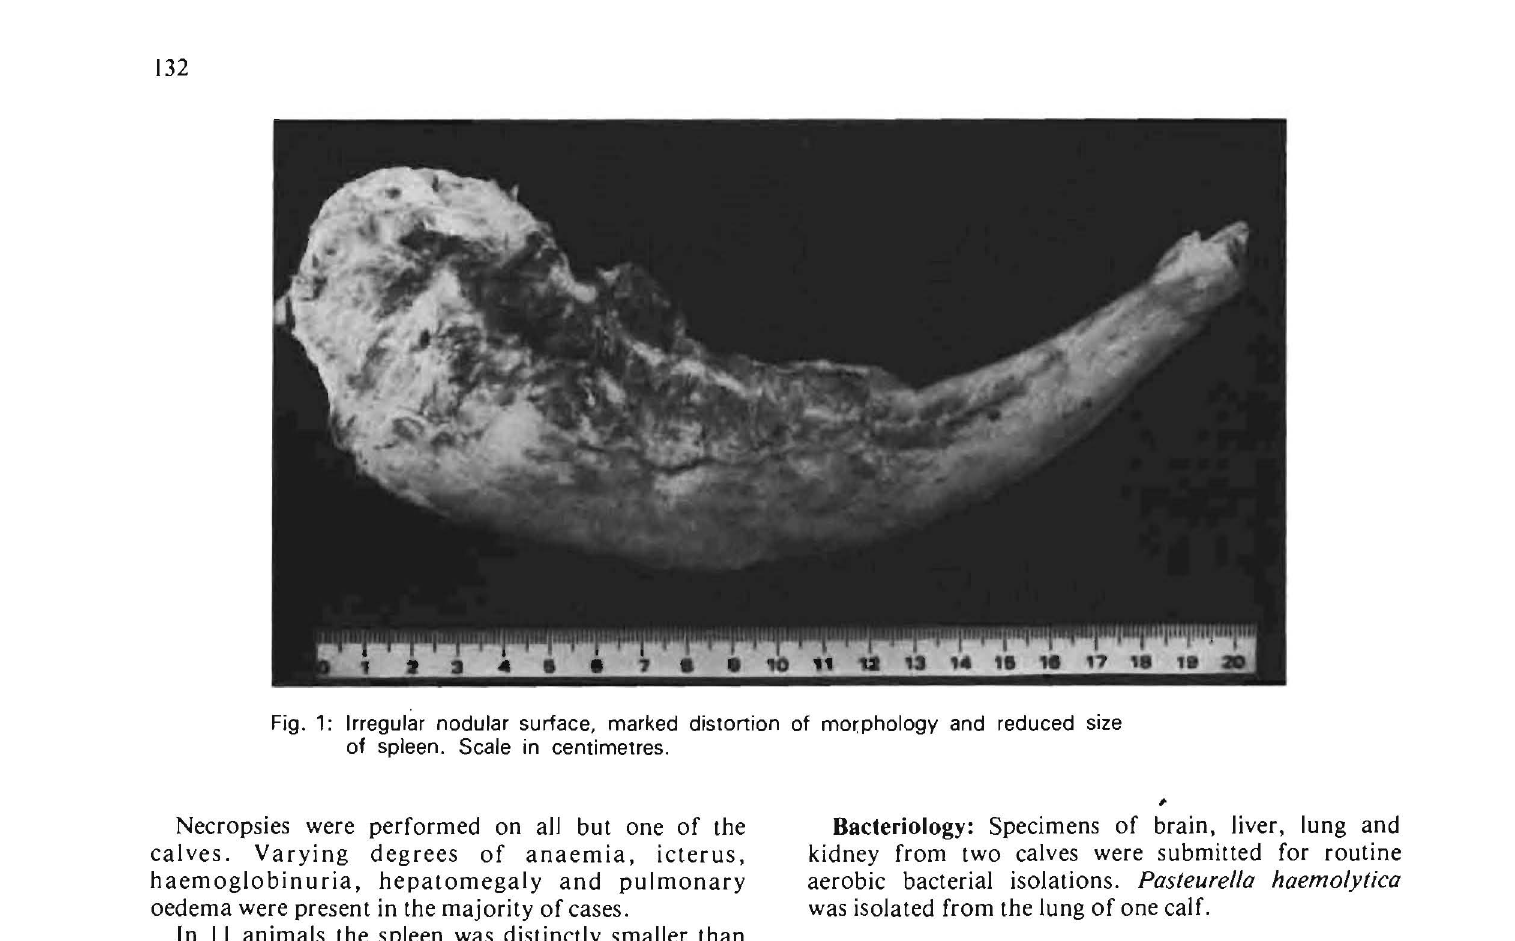
Fig. 1: Irregular nodular surface, marked distortion of mOrphology and reduced size of spleen. Scale in centimetres.